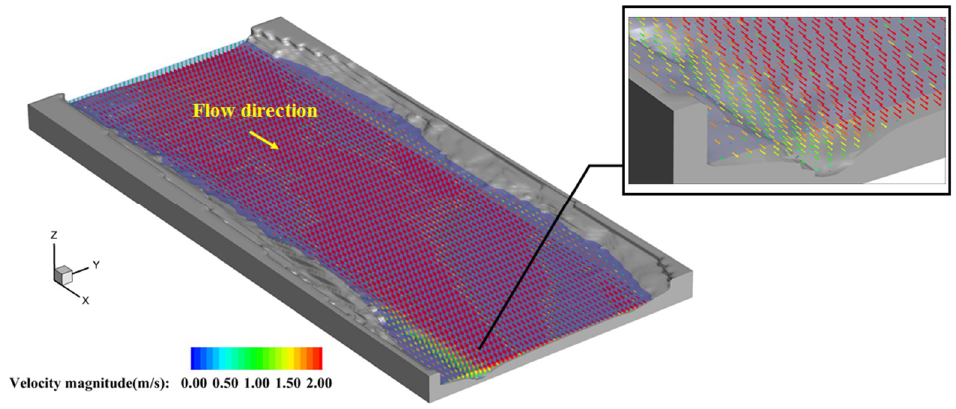
Figure 6. The numerical results on 3D flow field of the target reach in Case No.1.